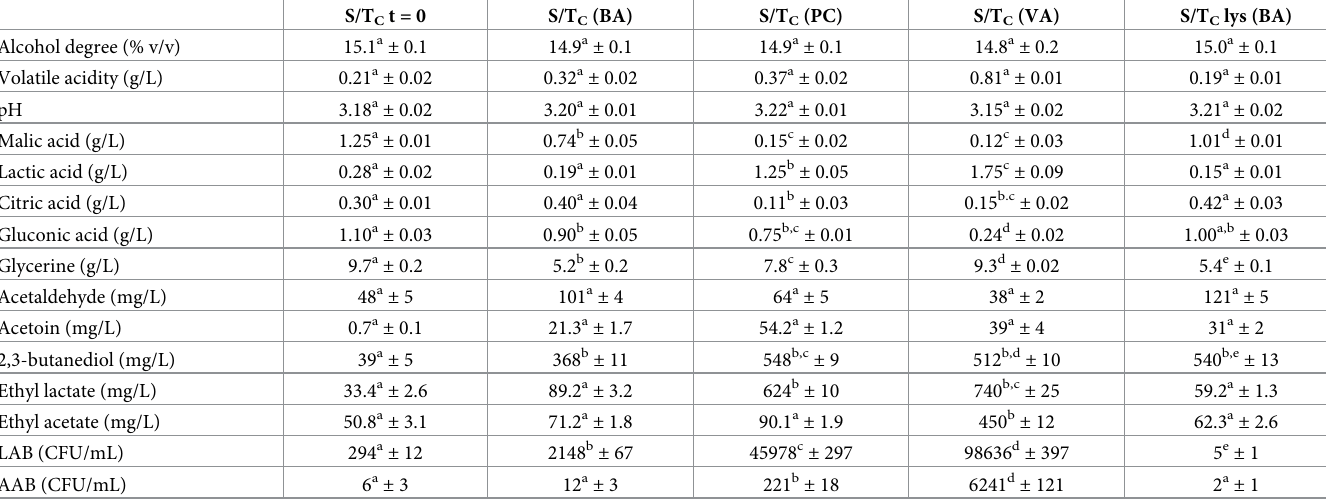
Table 5. Evolution of analytical composition of the S/T C "sobretablas" casks sets classified as PC, BA and VA after 1 year of aging.